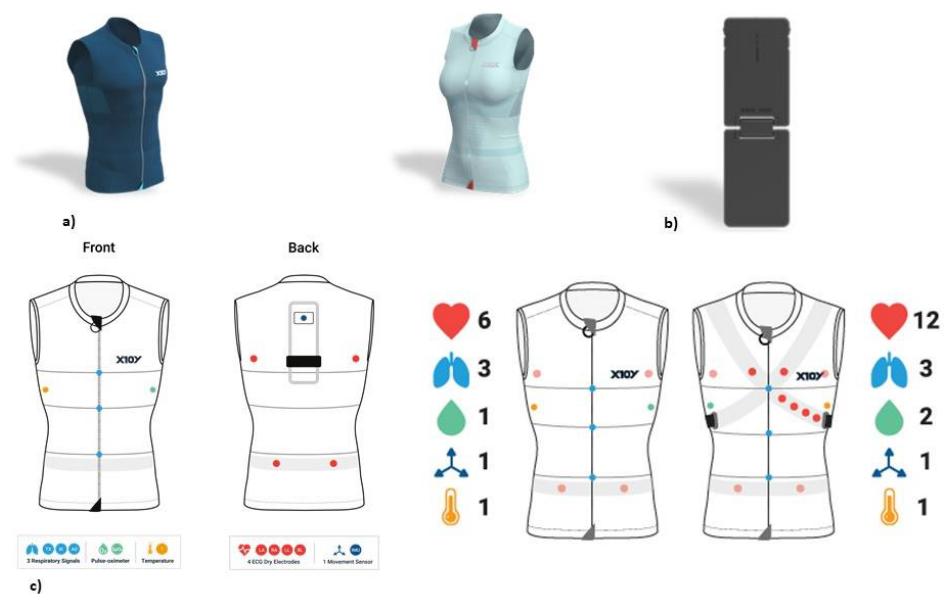
Figure 1. ( a ) Healer R2 wearable devices (male and female models); ( b ) logger KoR 1, connecting to the back of the garment for storing the data and transferring it via 4G/5G/Wi-Fi; ( c ) embedded sen- sors to detect heart rate, respiratory rate, temperature, saturation and